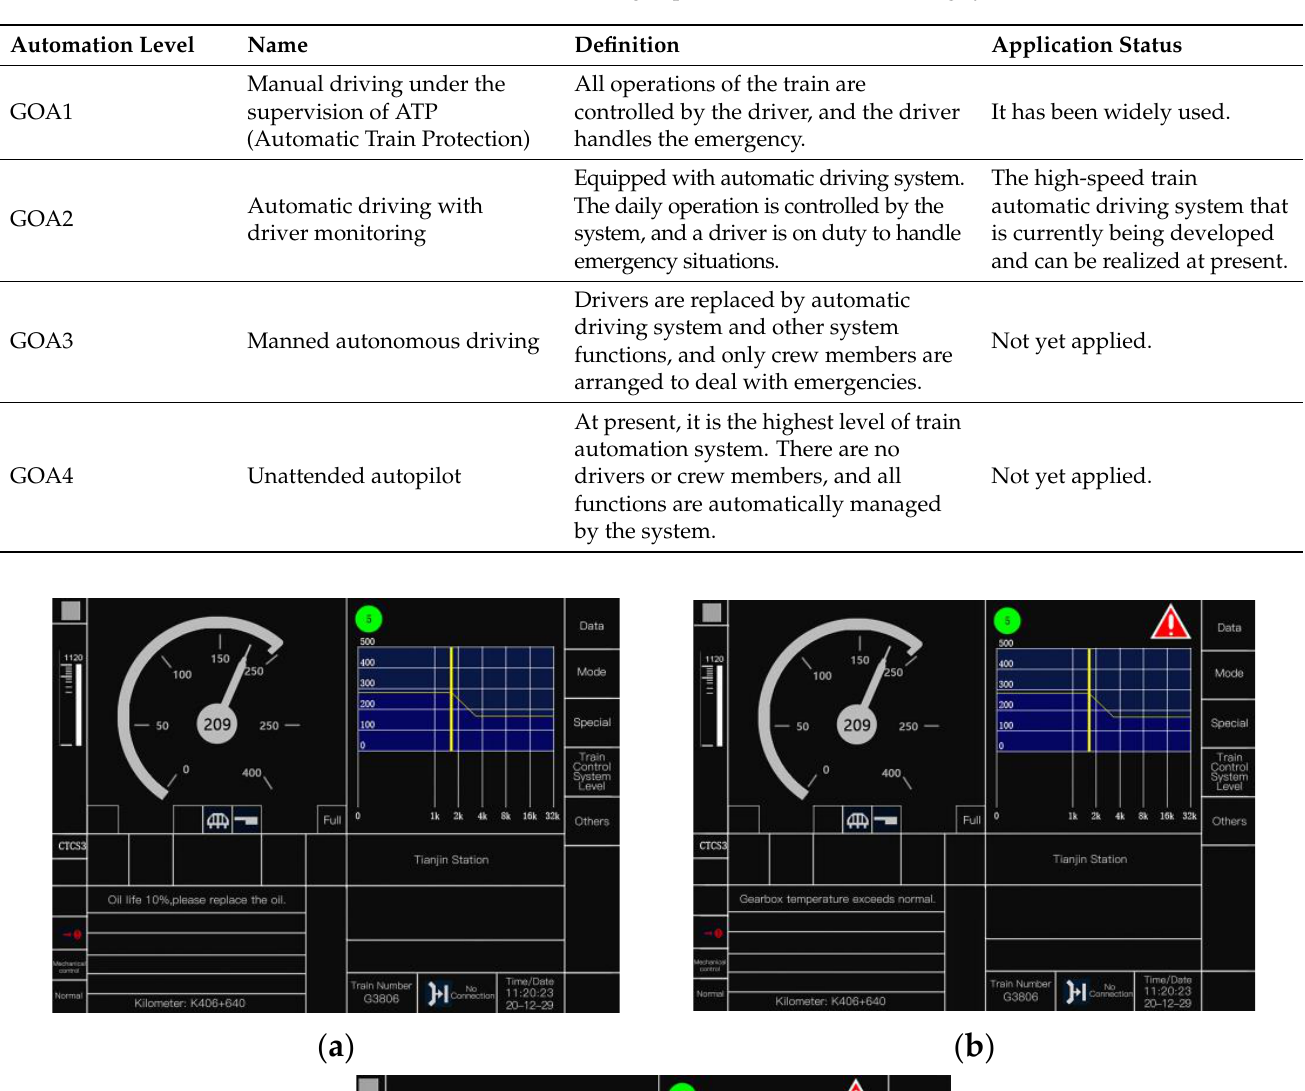
Table 1. Automation level of high-speed train automatic driving system.